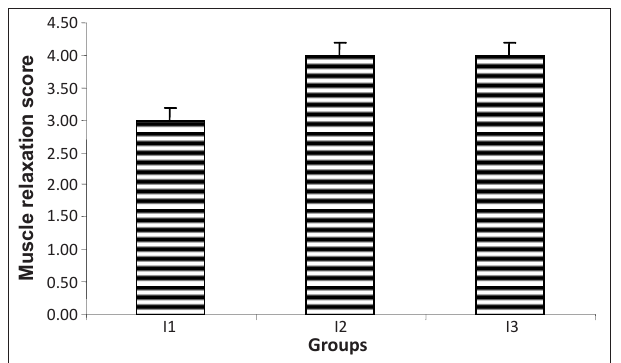
FIGURE 3: Median ± standard deviation of muscle relaxation in water buffaloes of different groups.